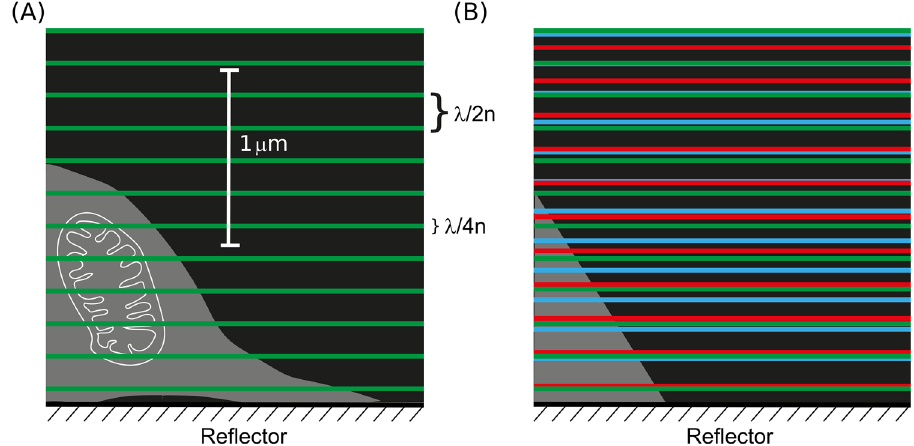
Figure 1. Schematic overview of TartanSW imaging. ( A ) single-wavelength-excitation SW principle. The cell (mitochondrion in white included for scale) adheres to the mirror, and is illuminated from above, as in an upright microscope. The green lines represent the anti-nodal planes formed by the SW pattern. Each anti-nodal plane has a thickness equivalent to λ/4n, and the spacing between the anti-nodal planes is equivalent to λ/2n, where λ is the respective wavelength and n is the refractive index. ( B ) multi-wavelength-excitation SW imaging (TartanSW) with blue, green and red lines representing the axial position of the anti-nodal planes from multiple SWs of different frequencies. In both ( A ) and ( B ) the anti-nodal plane thicknesses are reduced for clarity but the scaling of spatial frequencies is correct for 488 nm, 514 nm and 543 nm, assigned to false colours blue, green and red respectively. The medium was PBS (n = 1.34). For all frequencies, a nodal plane (not marked) lies in the surface of the